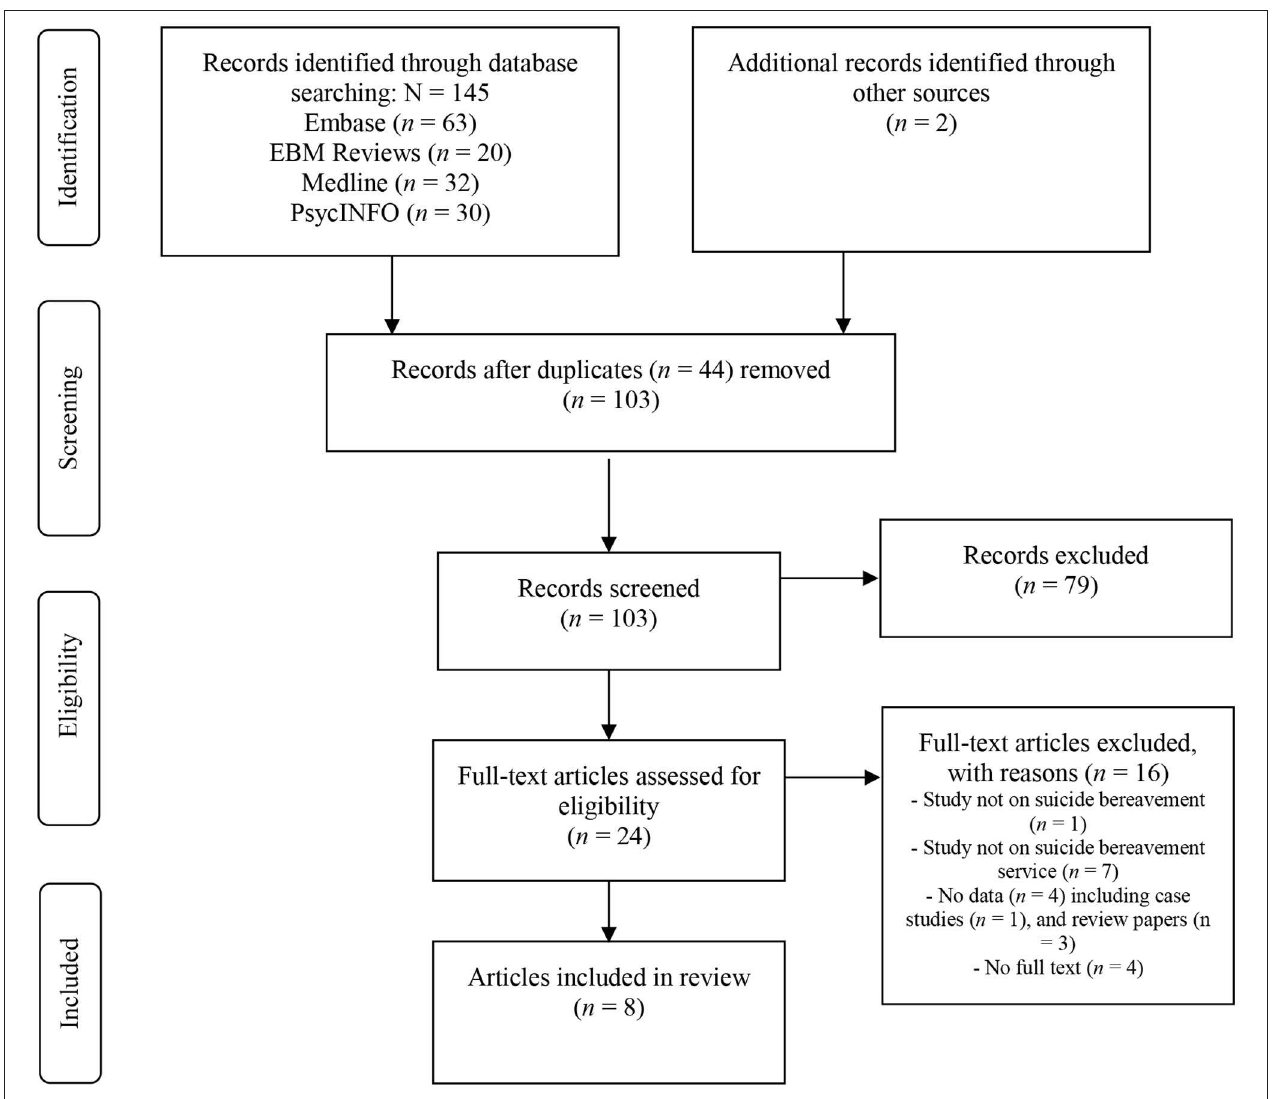
FIGURE 1 | PRISMA flow